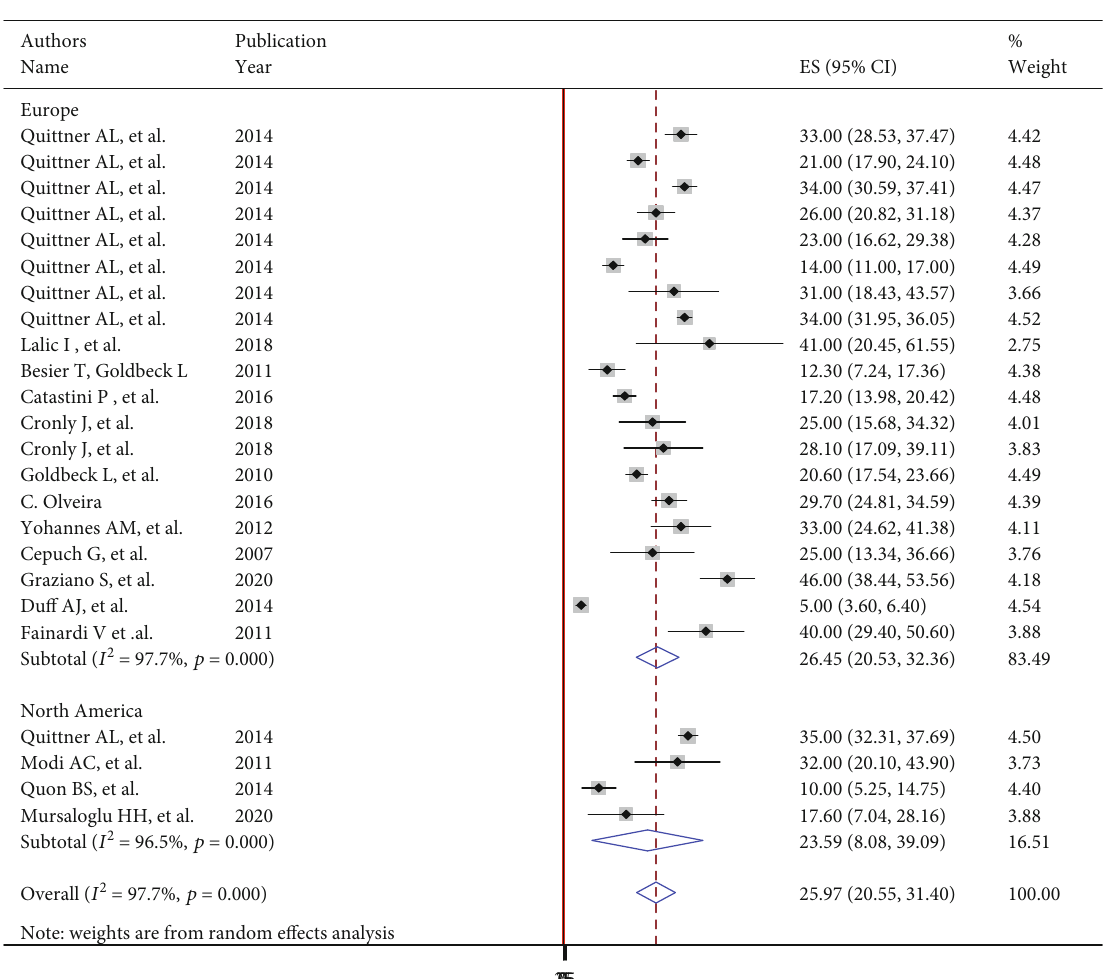
Figure 4: Subgroup analysis of global prevalence of anxiety in patients with cystic fi